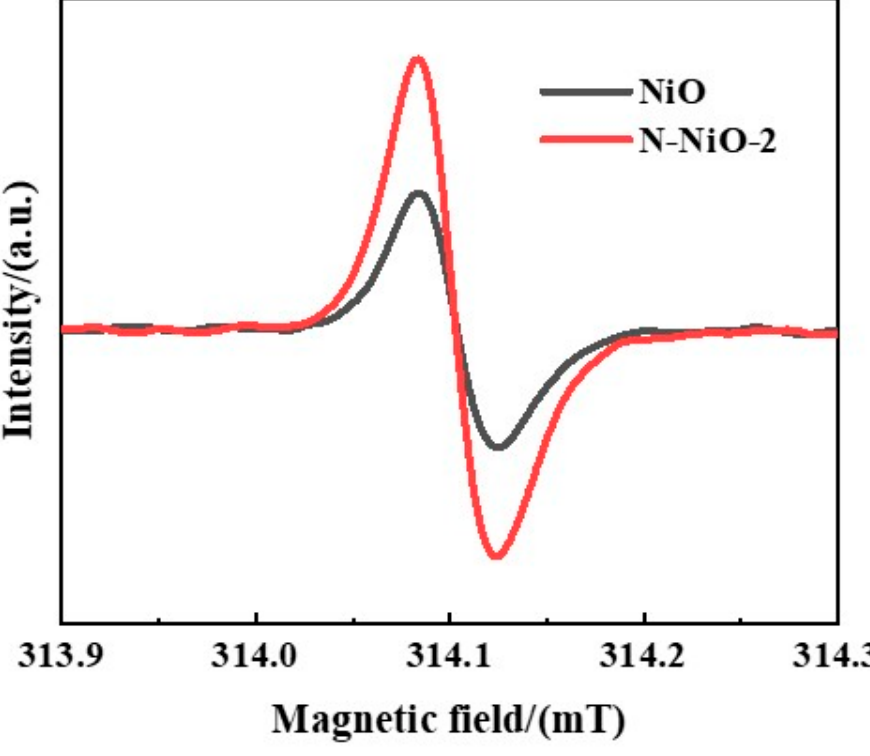
Figure 7. The EPR spectra of NiO and N-NiO-2.